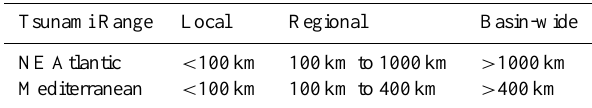
Table 3. Spatial ranges for tsunamis occurring in the NEAM region as adopted by the